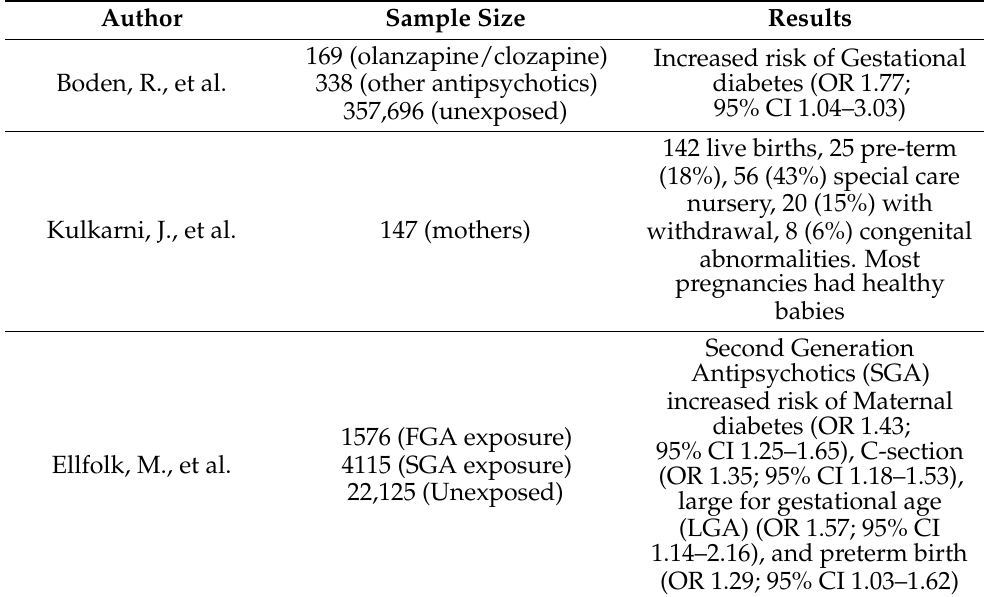
Table 1. Summarized case studies assessed including author, sample size, and